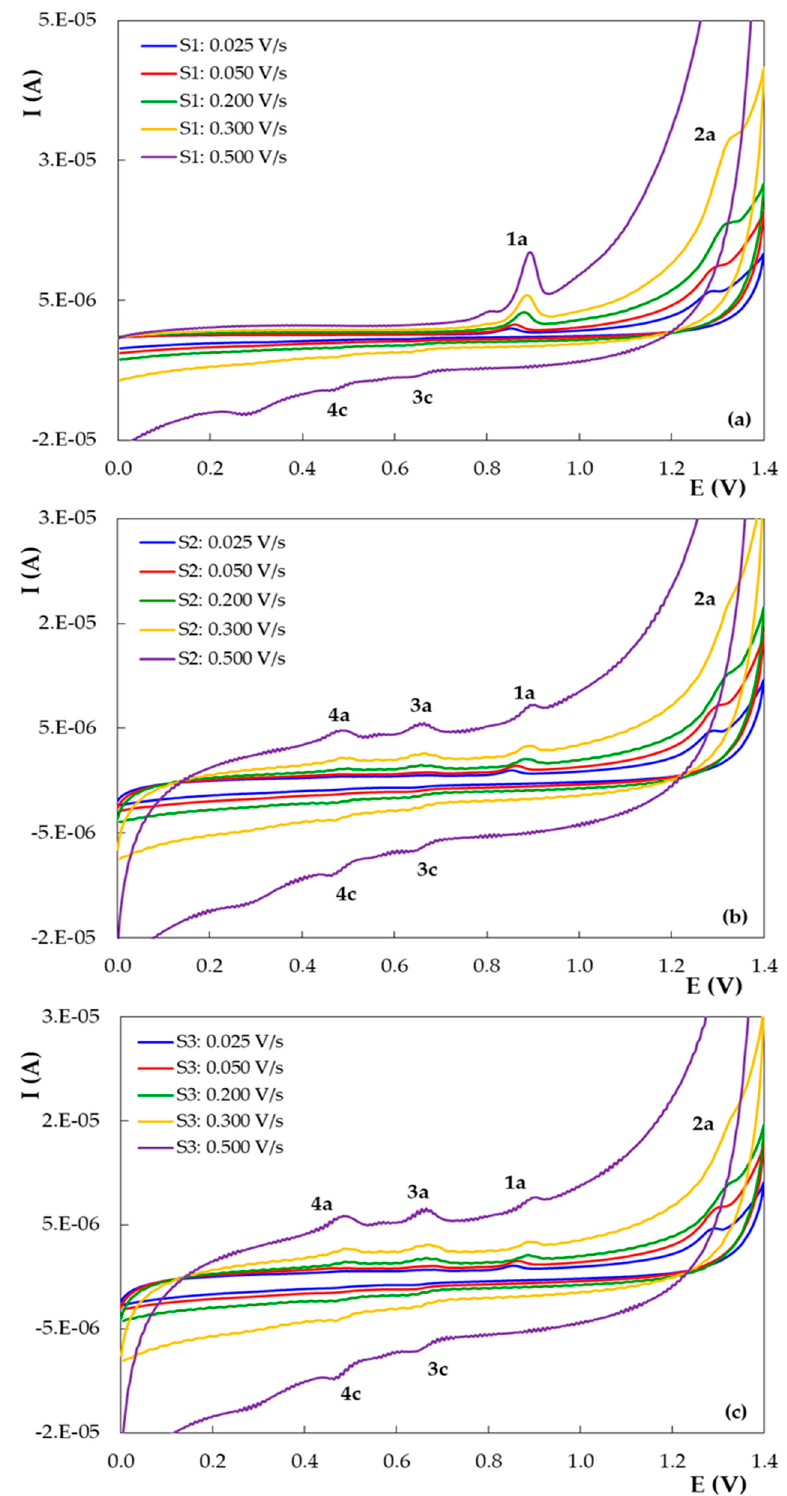
Figure 8. Cyclic voltammograms recorded at different scan rates on PGE_H for 1.00 × 10 − 5 mol/L DIO in 0.10 mol/L H 2 SO 4 : ( a ) first scan; ( b ) second scan; ( c ) third